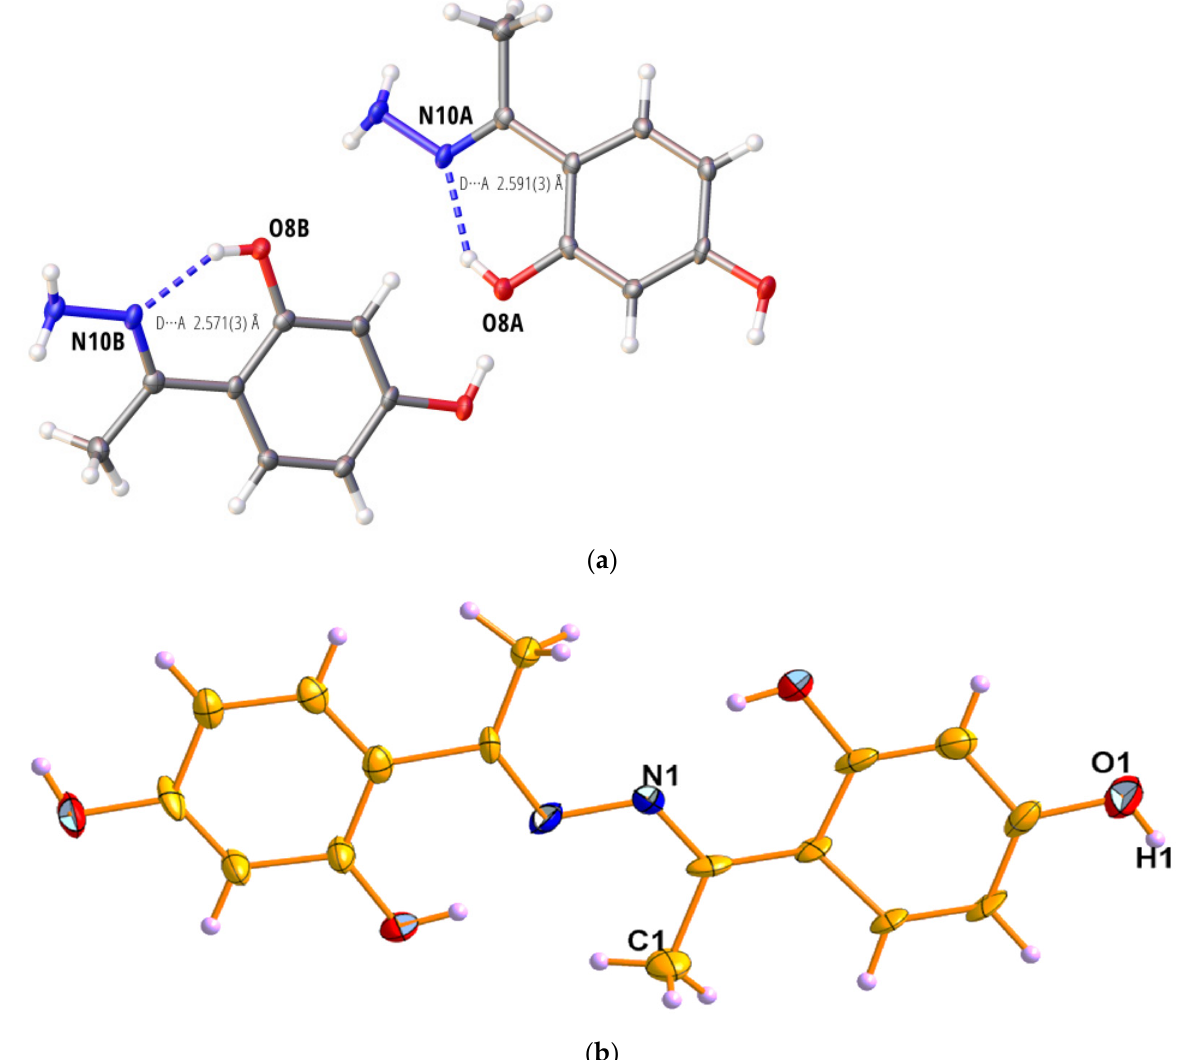
Figure 1. ORTEP diagrams of compounds ( a ) 1 and ( b ) 2 . The displacement ellipsoids are drawn at the 50% probability level.